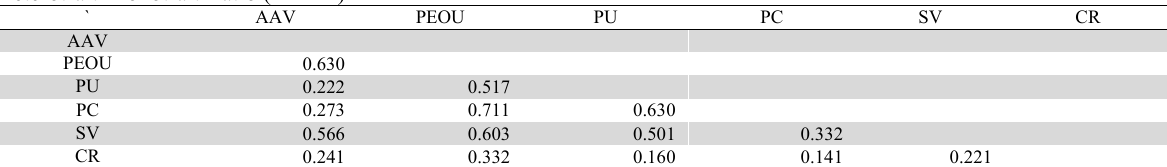
Heterotrait-Monotrait Ratio